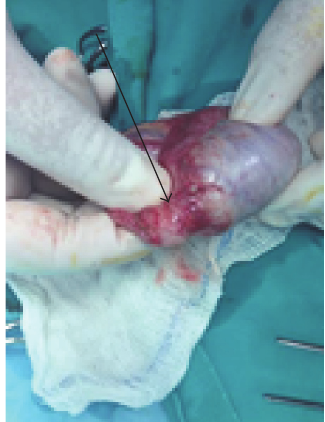
Figure 1: Solid hypoperfused, hyperechoic, 1.3 × 1.1cm in size mass localized at the tail of the epididymis. Notice the 2 small hypoechoic lesions inside the mass.